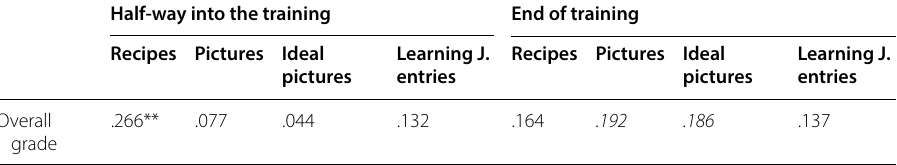
Italic values indicate significance of p value ( p < 0.05) ** p <